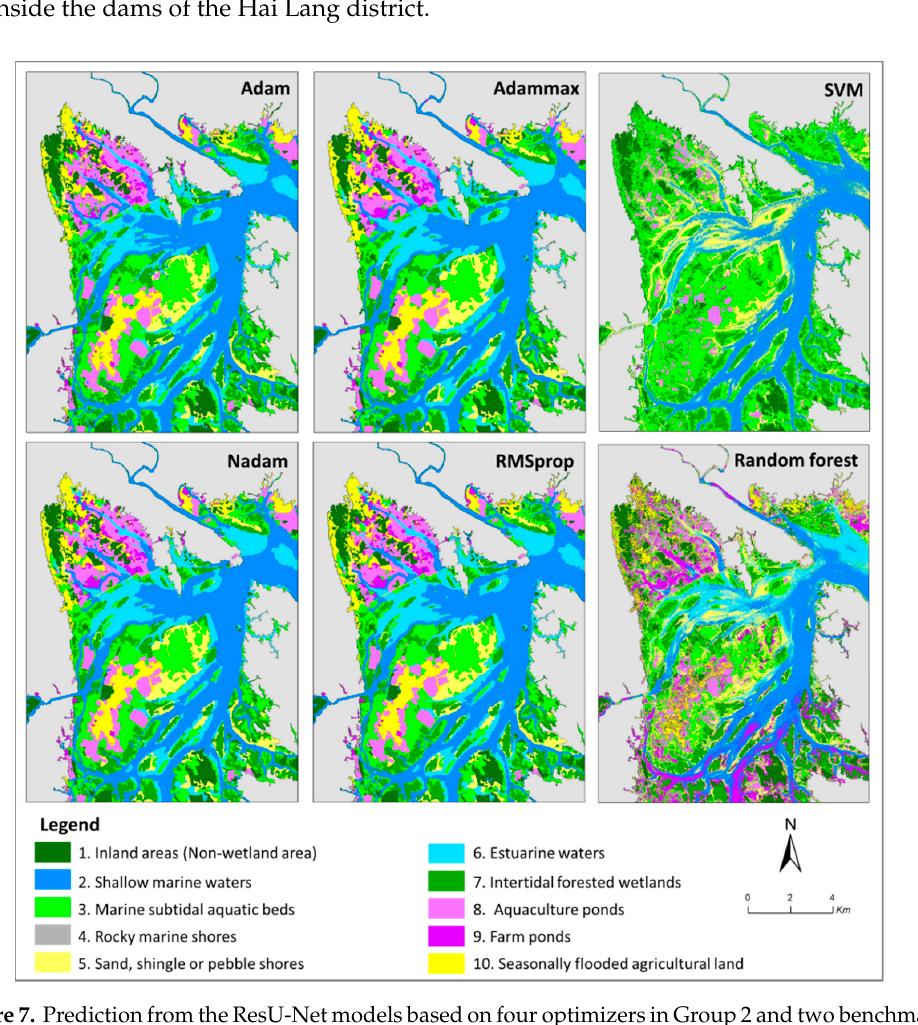
Figure 7. Prediction from the ResU-Net models based on four optimizers in Group 2 and two benchmark models in Group 3. Table 3. Accuracy values for the ResU-Net models using six optimizer functions.